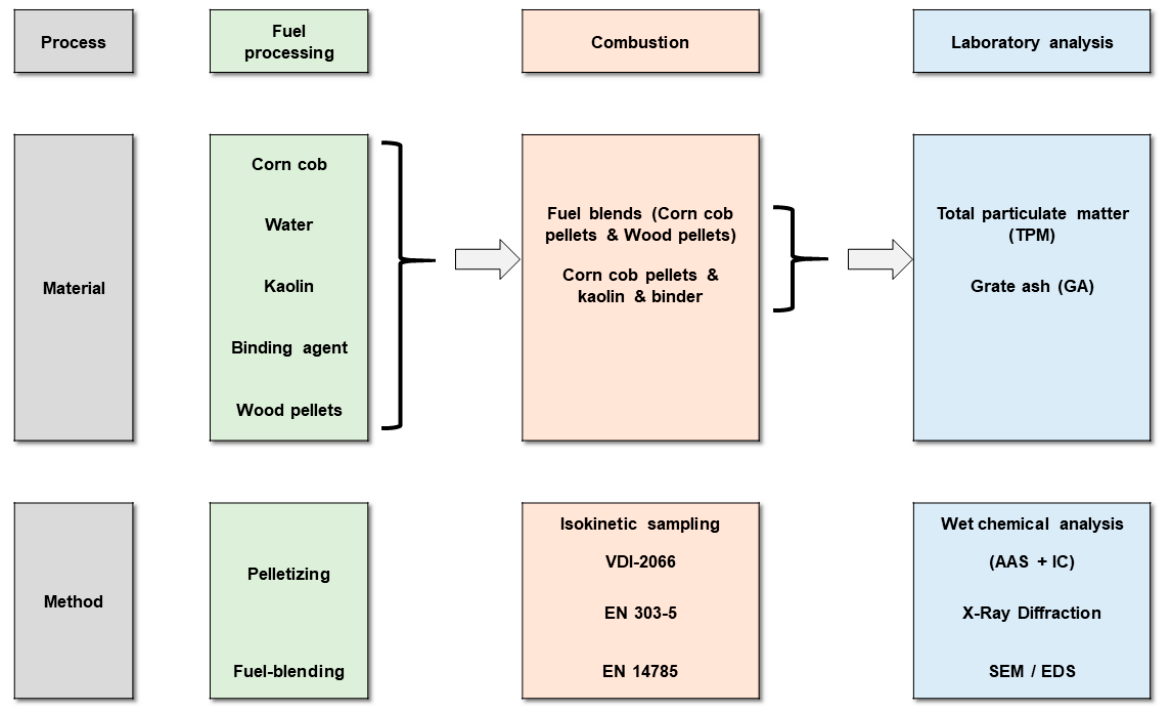
Figure 1. Investigation procedure.